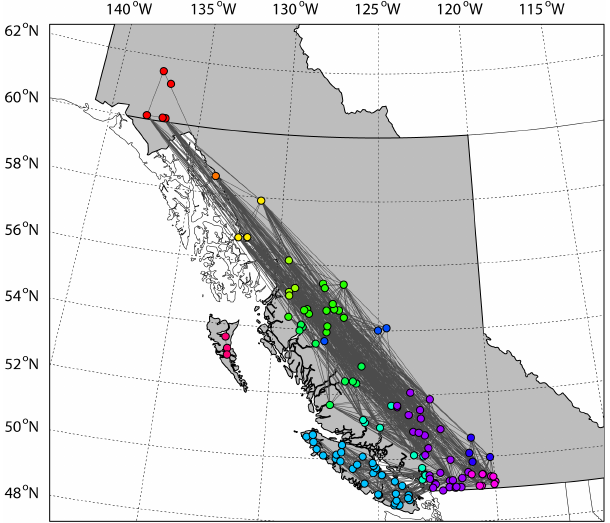
Figure 3. Georeferenced representation of the streamflow network. A line is drawn between each pair of stations if their linear corre- lation coefficient exceeds 0.7. The station colours are based on the WSC designated subregion as in Fig. 2.